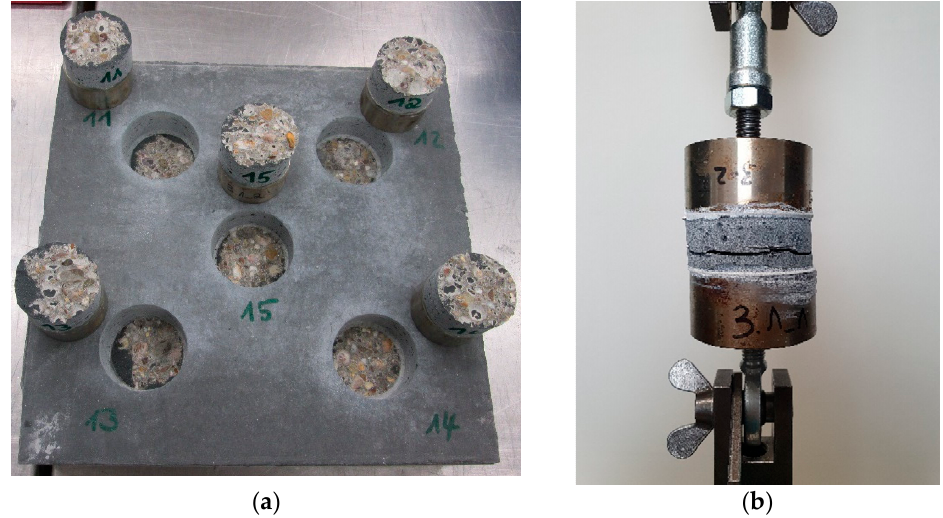
Figure 14. Lateral tensile tests. ( a ) Adhesive tensile strength, sample after testing; ( b ) Cohesive tensile strength of the TRM, test setup with broken specimen.